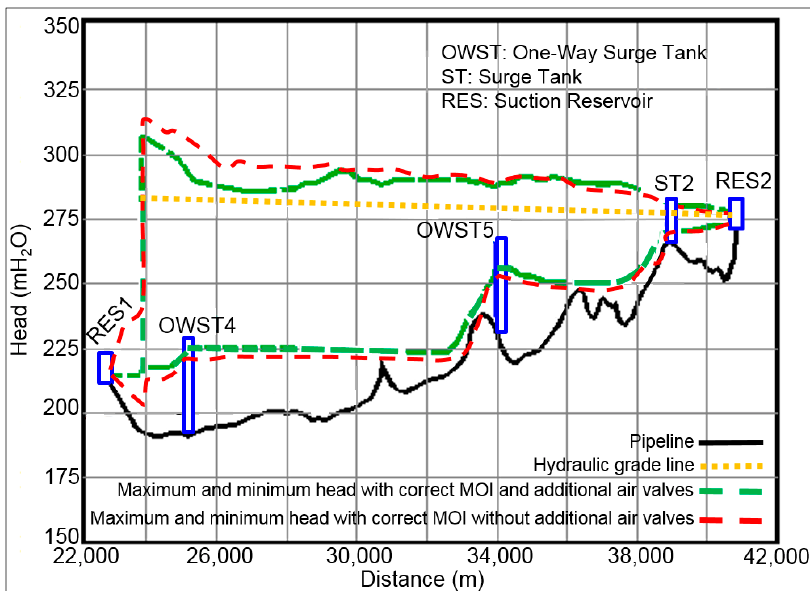
Figure 9. Maximum and minimum head envelopes for the second pipeline segment with and without additional air valves and the correct moment of inertia (MOI), following the simultaneous power failure of the two pumps at Pumping Plant 2.